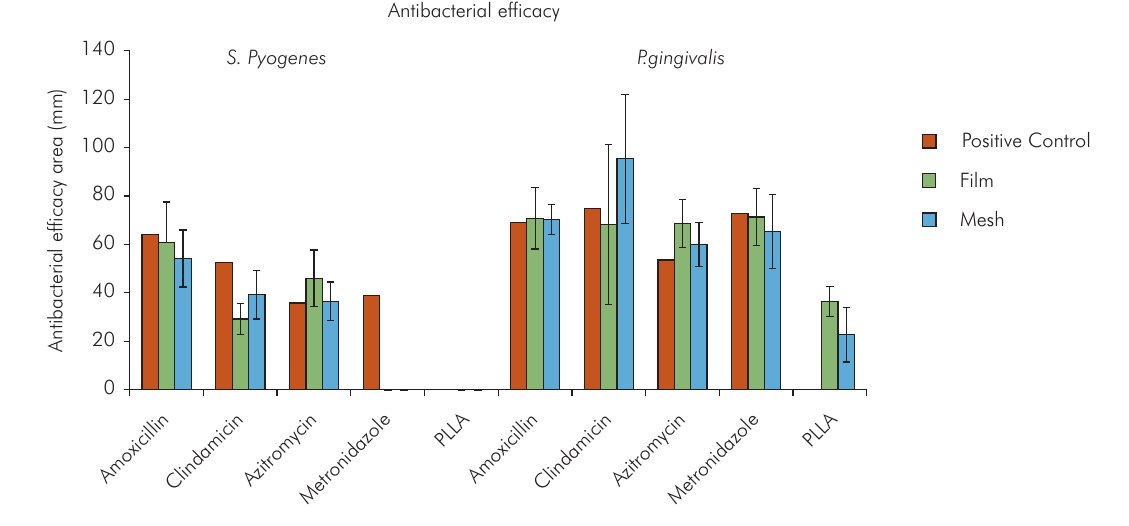
Figure 3. Antibacterial efficacy against S.Pyogenes (aerobic) and P.gingivalis (anaerobic).